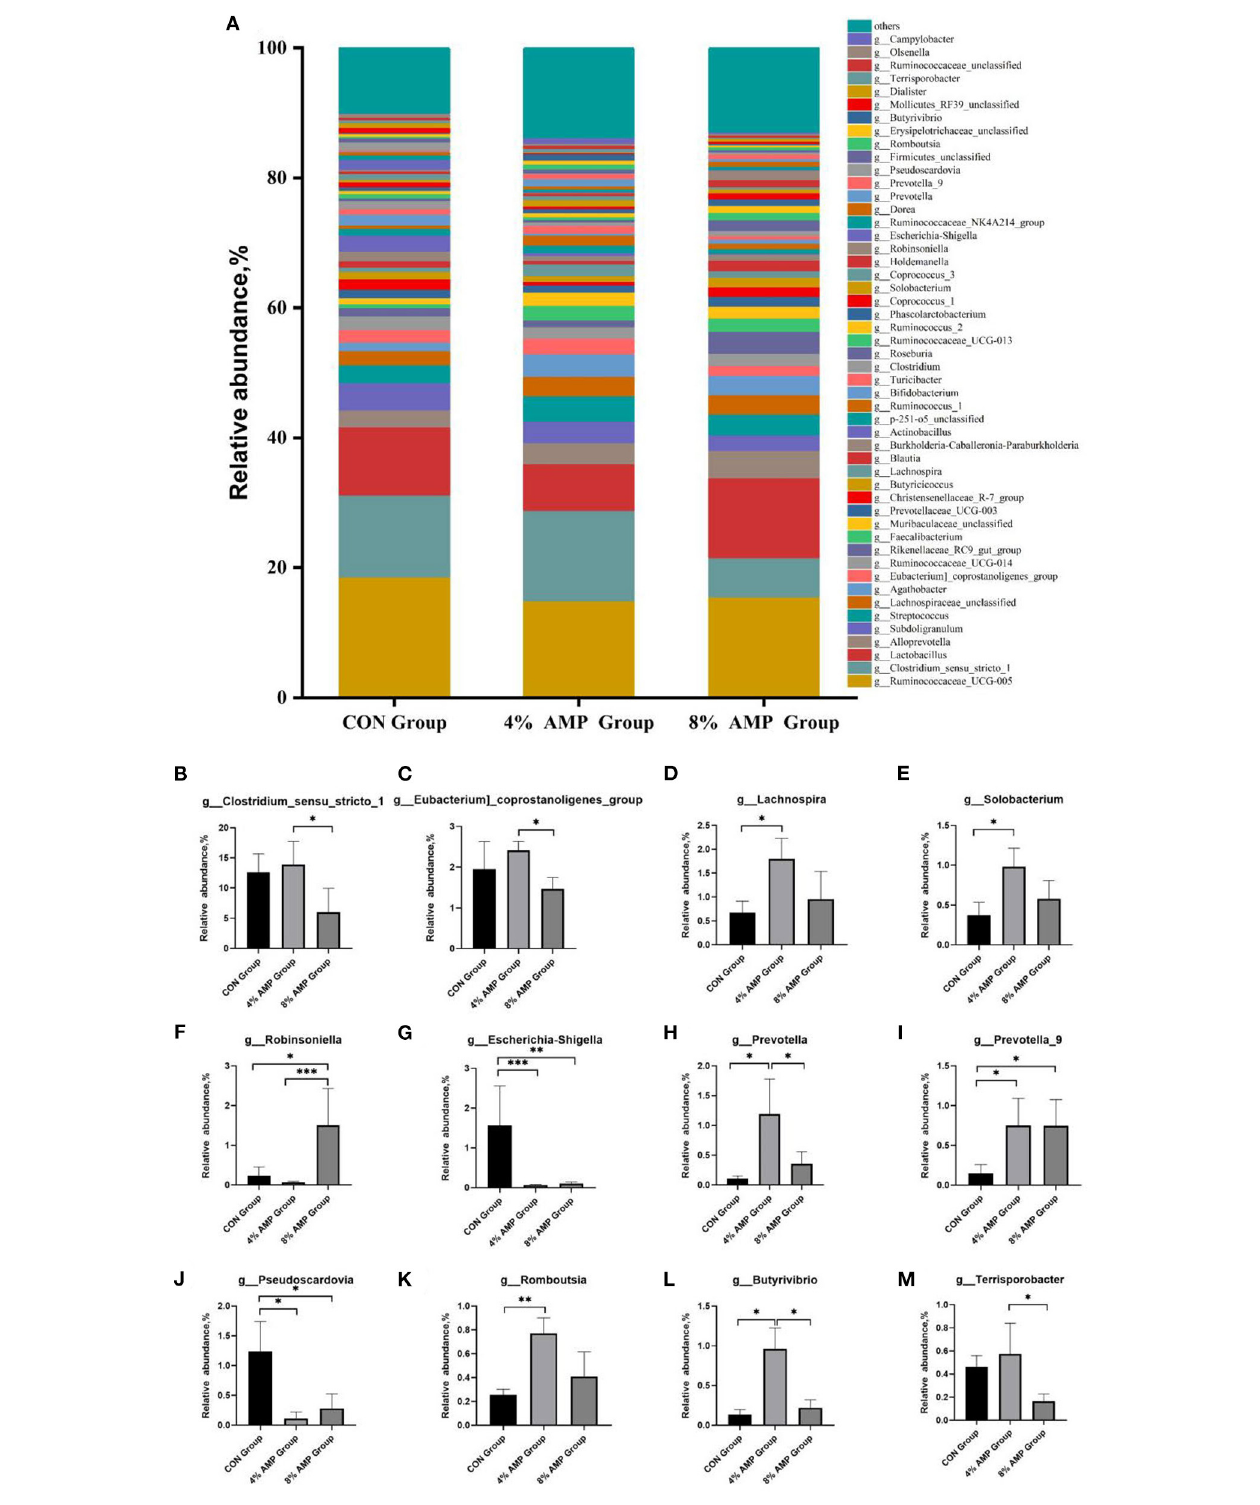
FIGURE 3 | Gut microbiota regulation by AMP at the genus level. (A) Relative abundance of cecal microbial genera. The relative abundances of the microbial genera g__Clostridium_sensu_stricto_1 (B) , g__Eubacterium]_coprostanoligenes_group (C) , g__Lachnospira (D) , g__Solobacterium (E) , g__Robinsoniella (F) , g__Escherichia-Shigella (G) , g__Prevotella (H) , g__Prevotella_9 (I) , g__Pseudoscardovia (J) , g__Romboutsia (K) , g__Butyrivibrio (L) , and g__Terrisporobacter (M) in each group. Data are expressed as the means ± SDs, n = 6, * P < 0.05, ** P < 0.01, *** P < 0.001.